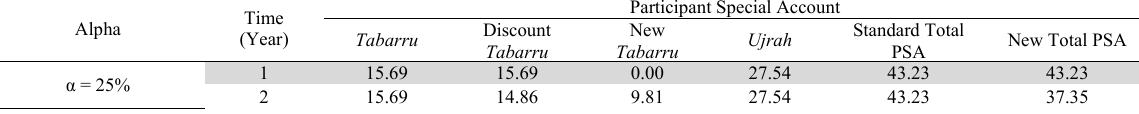
A comparison of the value of participant special accounts under equity-linked